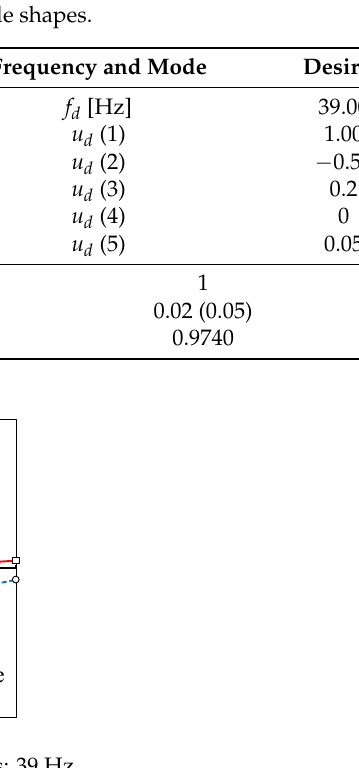
Figure 23. Comparison of desired and attained modes: 39 Hz.